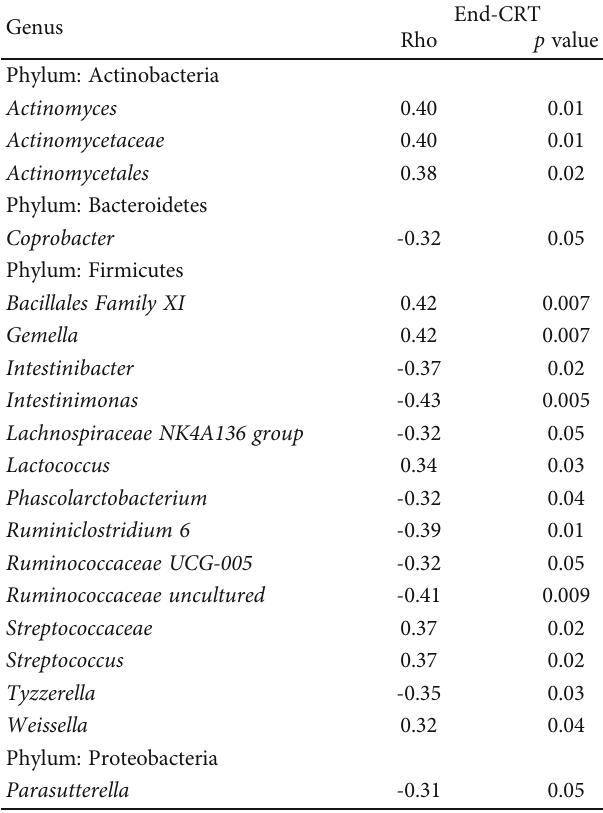
Table 3: Statistically signi fi cant correlations between genus relative abundances and the Hamilton Depression Rating Scale scores at the end of